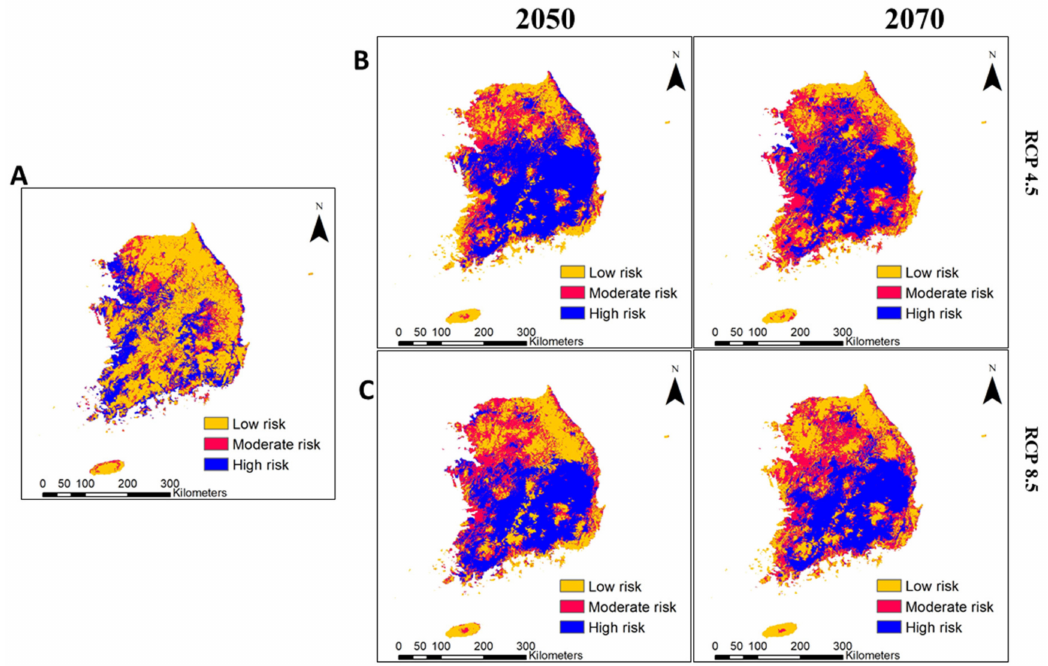
Figure 6. Predicted invasion risk of introduced alien plants in South Korea. The invasion risk assessment is divided into three categories: low, moderate, and high. These three categories are indicated by yellow, red, and blue in the figure. Spatial invasion predictions under the current ( A ) and future ( B , C ) environmental conditions in South